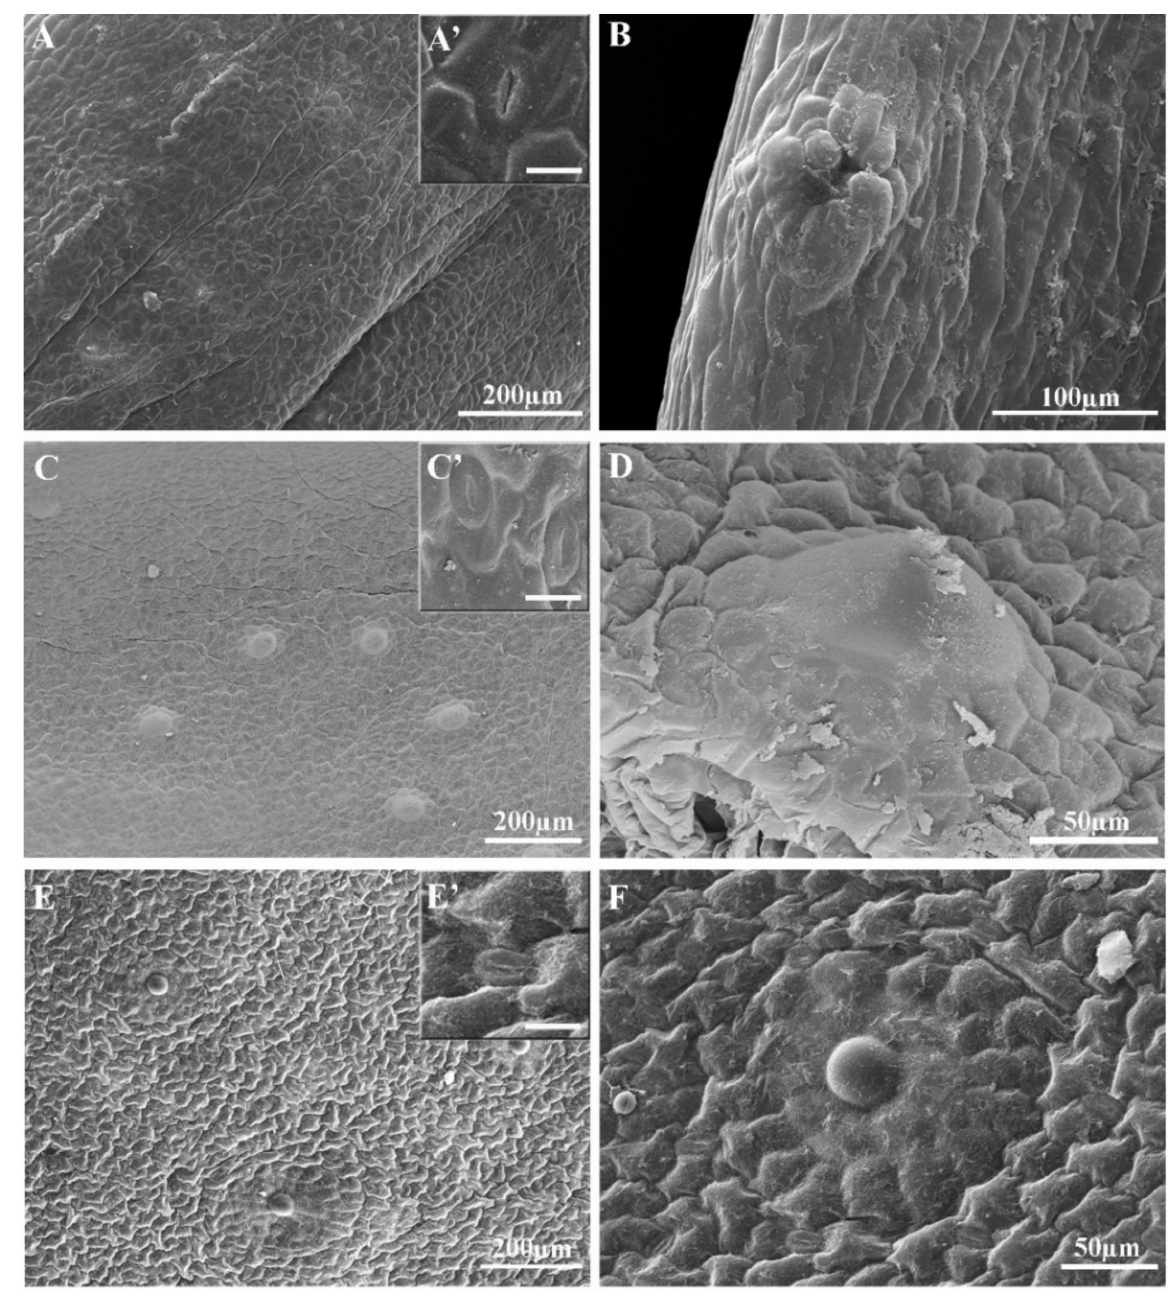
Figure 5. Scanning micrographs of the epidermal tissue from the abaxial leaf surface of M. maritima leaves from the jar ( A , A (cid:48) , B ); Plantform ( C , C (cid:48) , D ) and in vivo plants ( E , E (cid:48) , F ). ( A , C , E ) Leaf epidermis; ( A (cid:48) , C (cid:48) , E (cid:48) ) stomata and ( B , D , F ) wax gland. In ( A , C , E ), bars = 200 µ m; in ( B ), bar = 100 µ m and in ( A (cid:48) , C (cid:48) , D , E (cid:48) , F ) bars = 50 µ